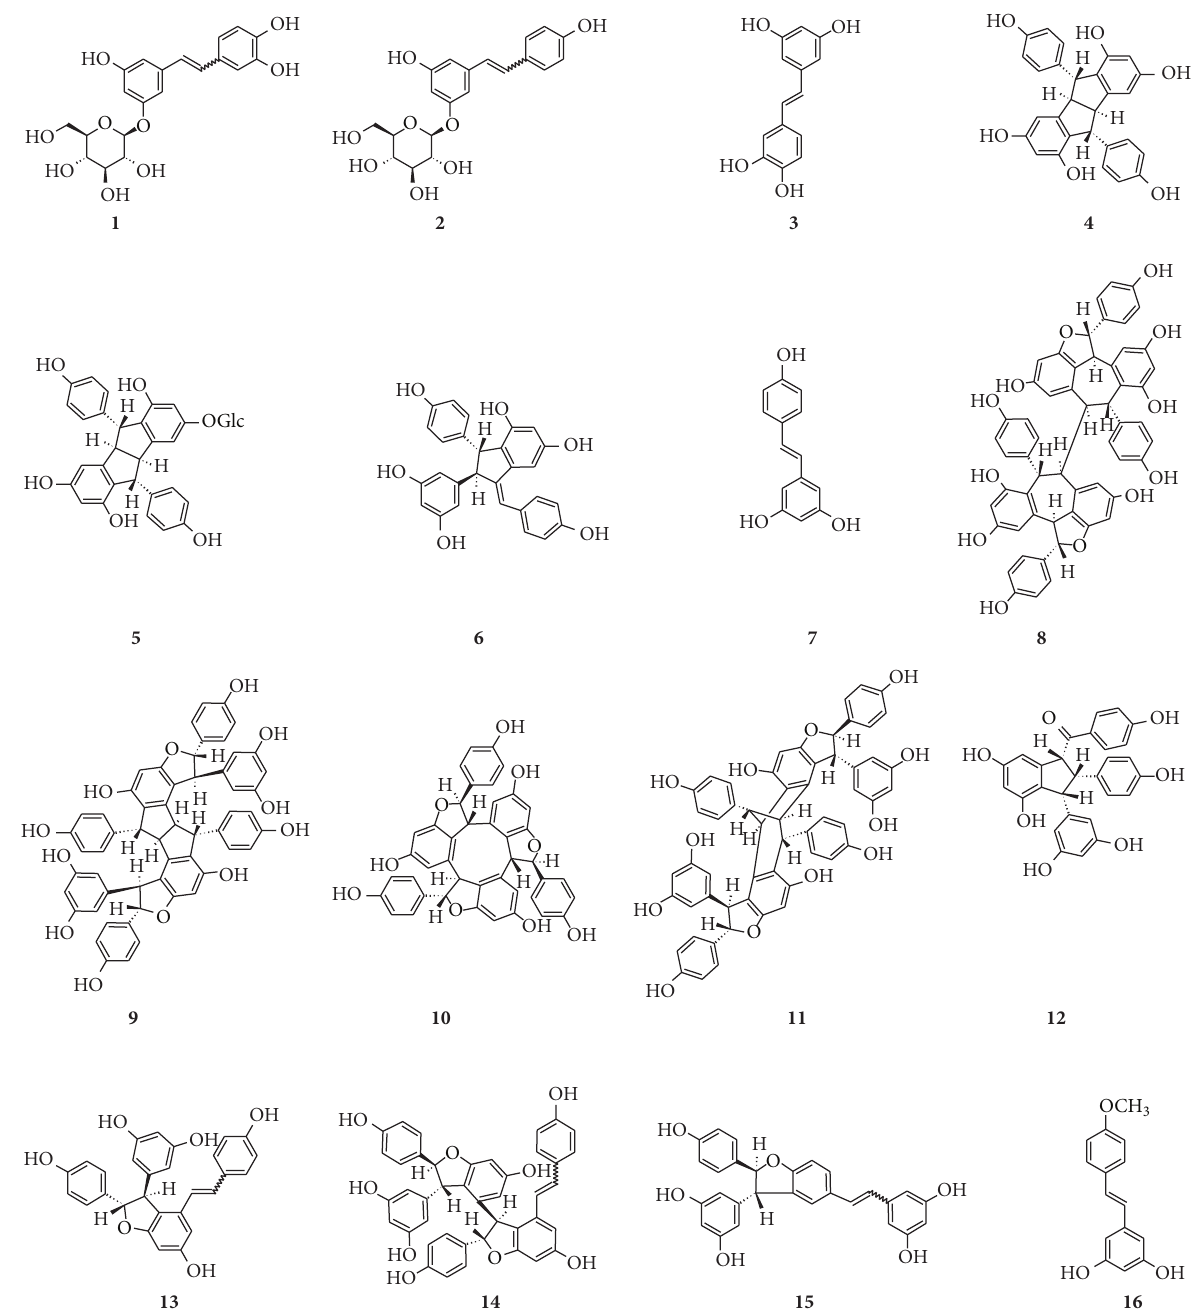
Figure 5: Principal stilbenes identified in vine tissues. ( 1 ) E - and Z -astringin, ( 2 ) E - and Z -piceid, ( 3 ) piceatannol, ( 4 ) pallidol, ( 5 ) pallidol- 3- O -glucoside, ( 6 ) parthenocissin A, ( 7 ) trans -resveratrol, ( 8 ) hopeaphenol, ( 9 ) ampelopsin H, ( 10 ) 𝛼 -viniferin, ( 11 ) vaticanol C isomer, ( 12 ) caraphenol B, ( 13 ) E- and Z - 𝜀 -viniferin, ( 14 ) E - and Z -miyabenol C, ( 15 ) E - and Z - 𝛿 -viniferin, and ( 16 ) trans -resveratrol-4 󸀠 -methyl ether.